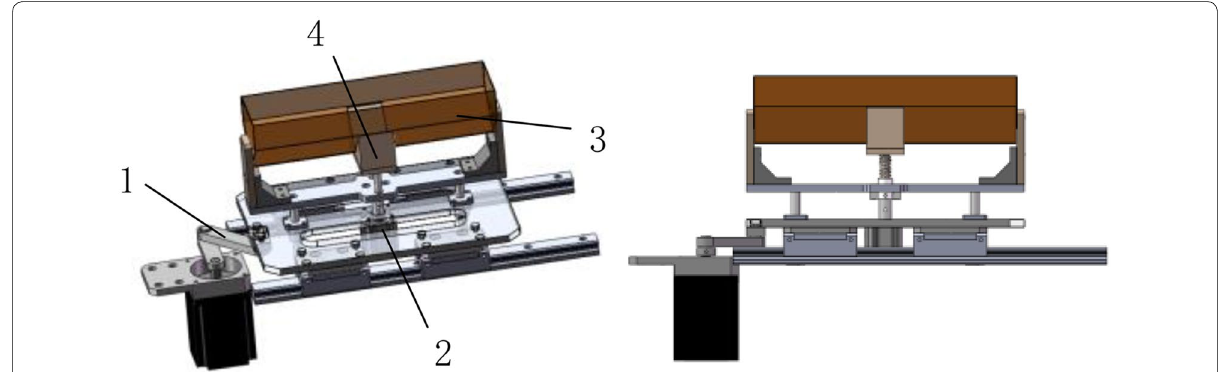
Figure 4 Compound vibration-type material-tidying mechanism diagram. 1. Crank slider mechanism; 2. Cylinder; 3. Material frame; 4. Reclaiming auxiliary